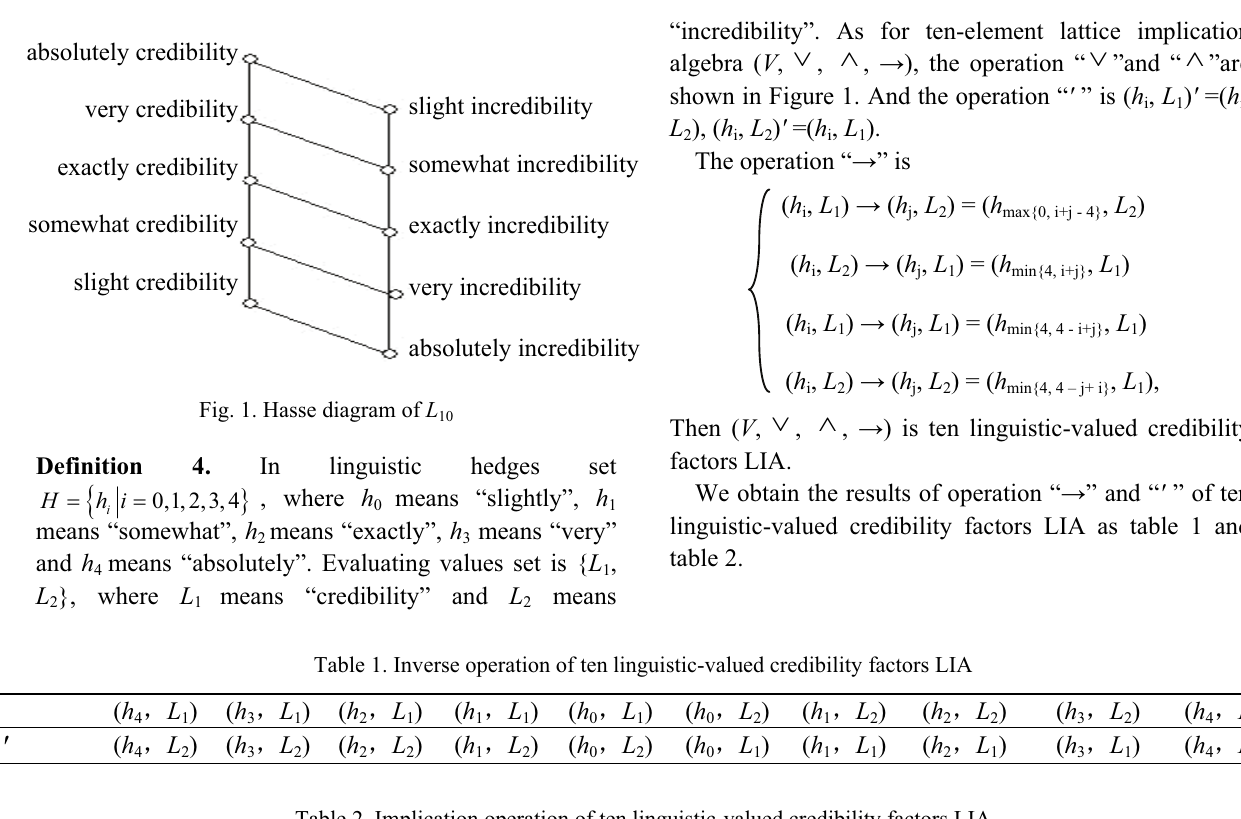
Table 2. Implication operation of ten linguistic-valued credibility factors